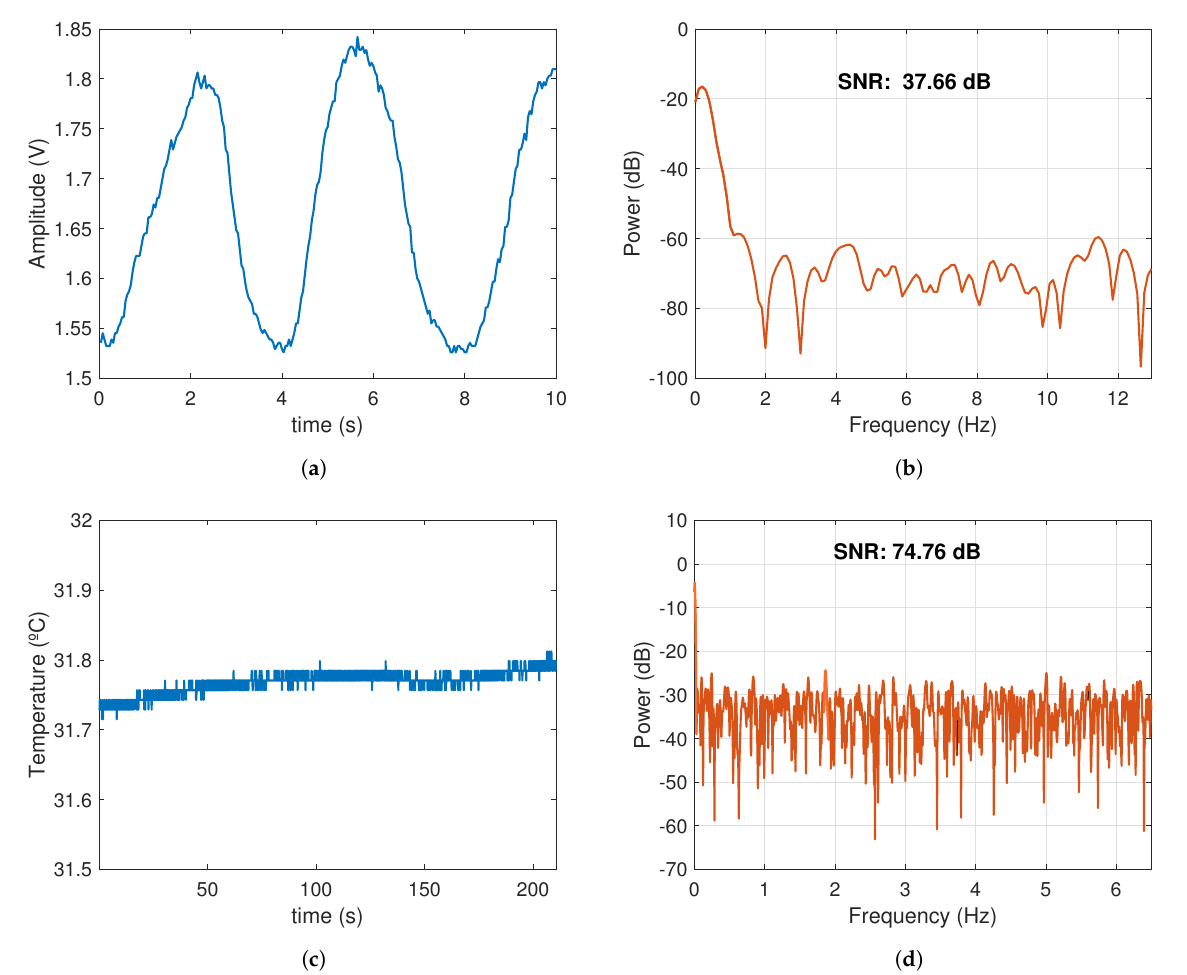
Figure 10. BR and ST signal segments and their SNR during sit-to-stand activity. ( a ) BR signal: 3 complete exhalation/inspiration cycles. ( b ) SNR of the BR signal. ( c ) ST changes during 200 s of exercise. ( d ) SNR of the ST